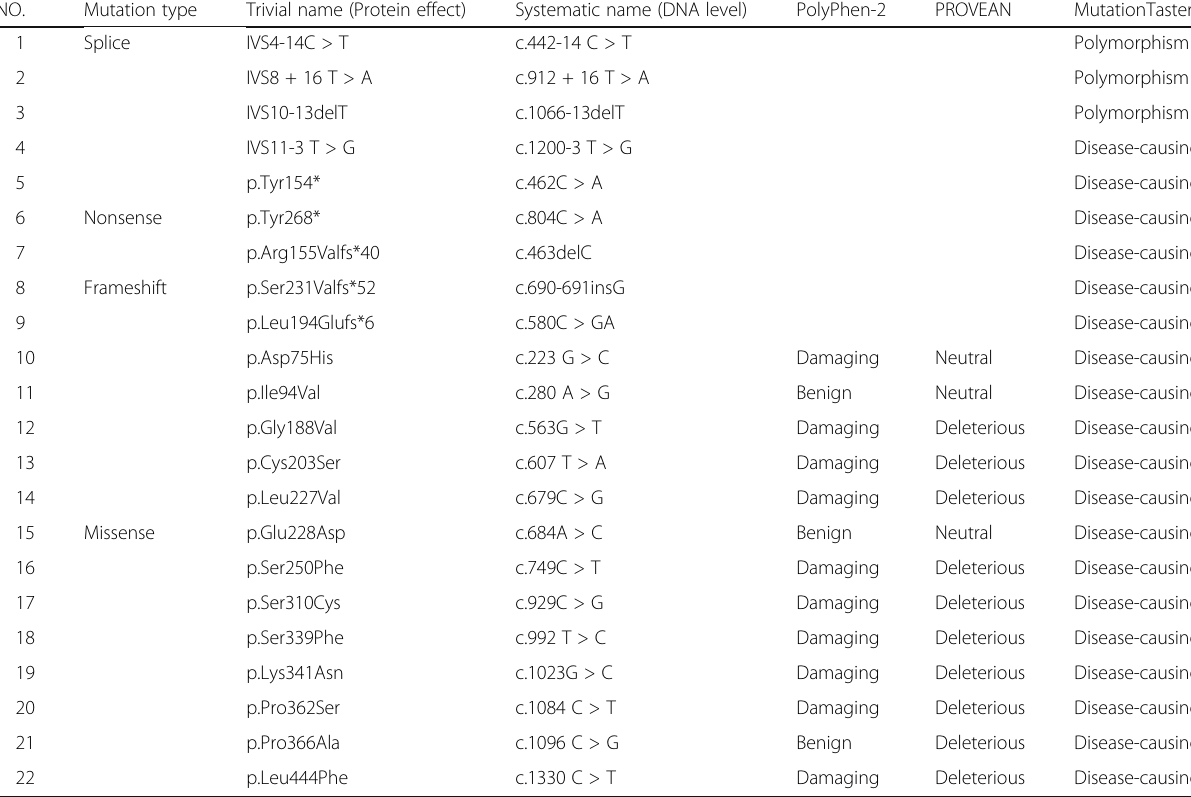
Table 3 Pathological analysis of the 22 novel variants of the PAH gene detected in this study